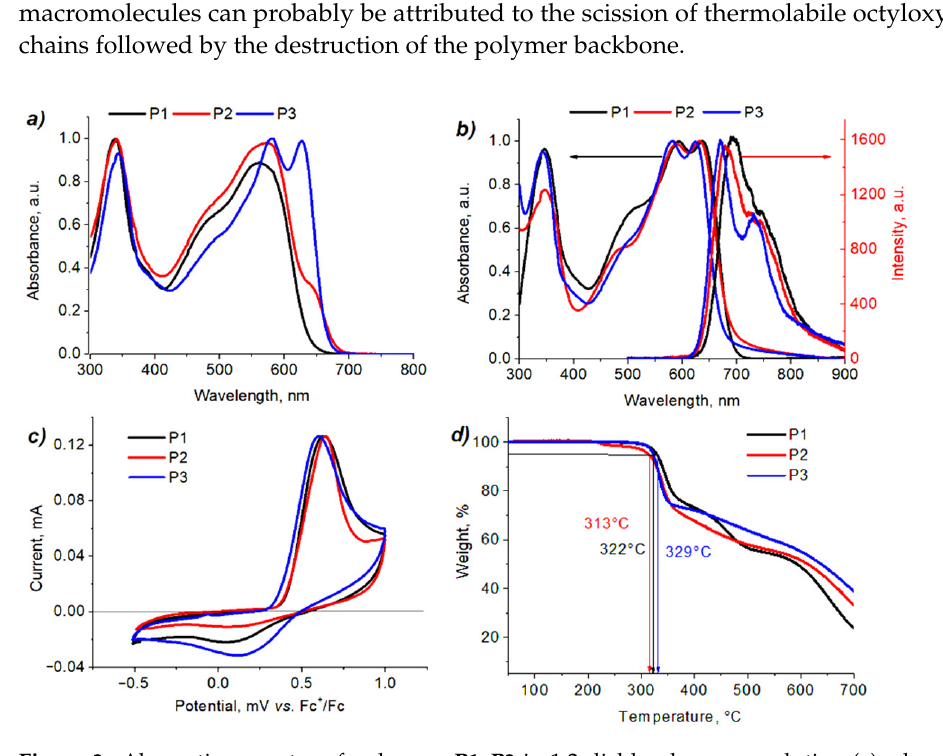
Figure 3. Absorption spectra of polymers P1 – P3 in 1,2-dichlorobenzene solution ( a ); absorption and emission spectra of thin films ( b ); cyclic voltammograms of polymer thin films (supporting electrolyte—0.1 M Bu 4 NPF 6 in acetonitrile, scan rate—50 mVs − 1 , glassy carbon disc electrode) ( c ); TGA curves of polymers P1 – P3 ( d ).